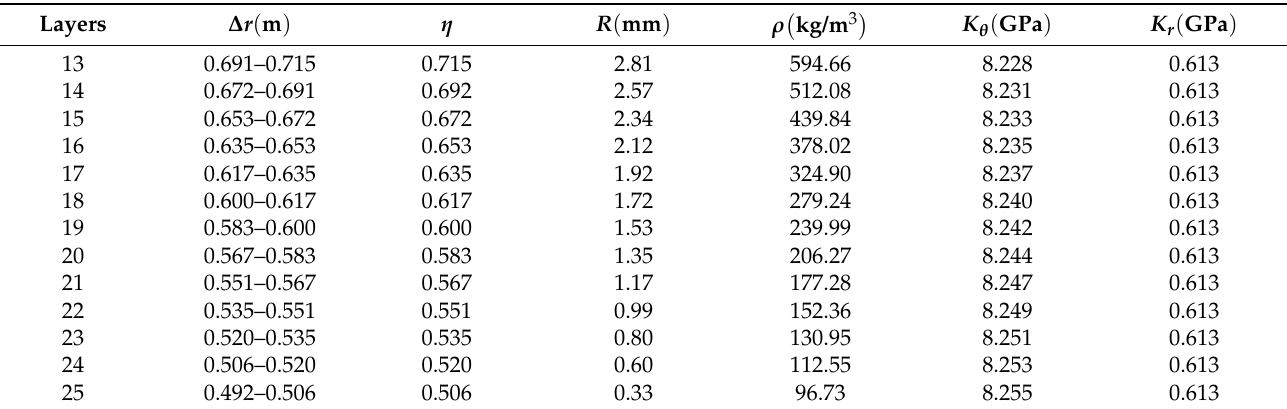
Table 2. Microstructure and homogenized property corresponding to each layer of PMs based on carbon fiber.